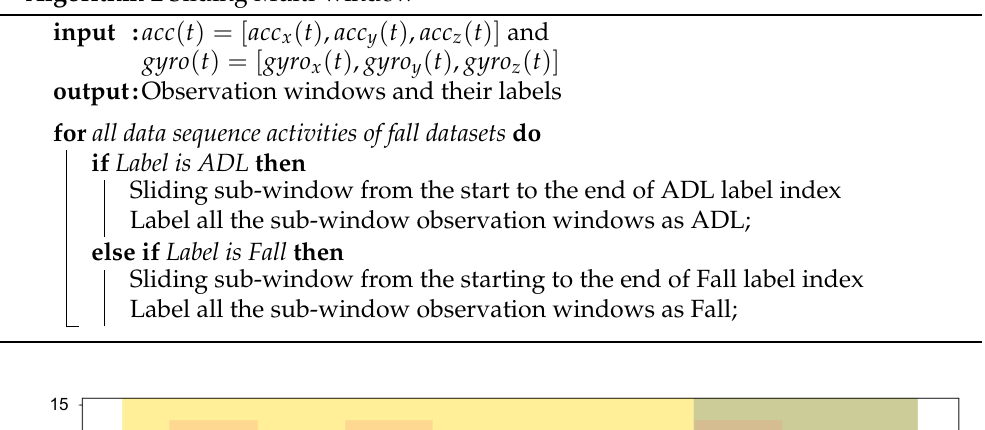
Algorithm 2 Sliding Multi-window